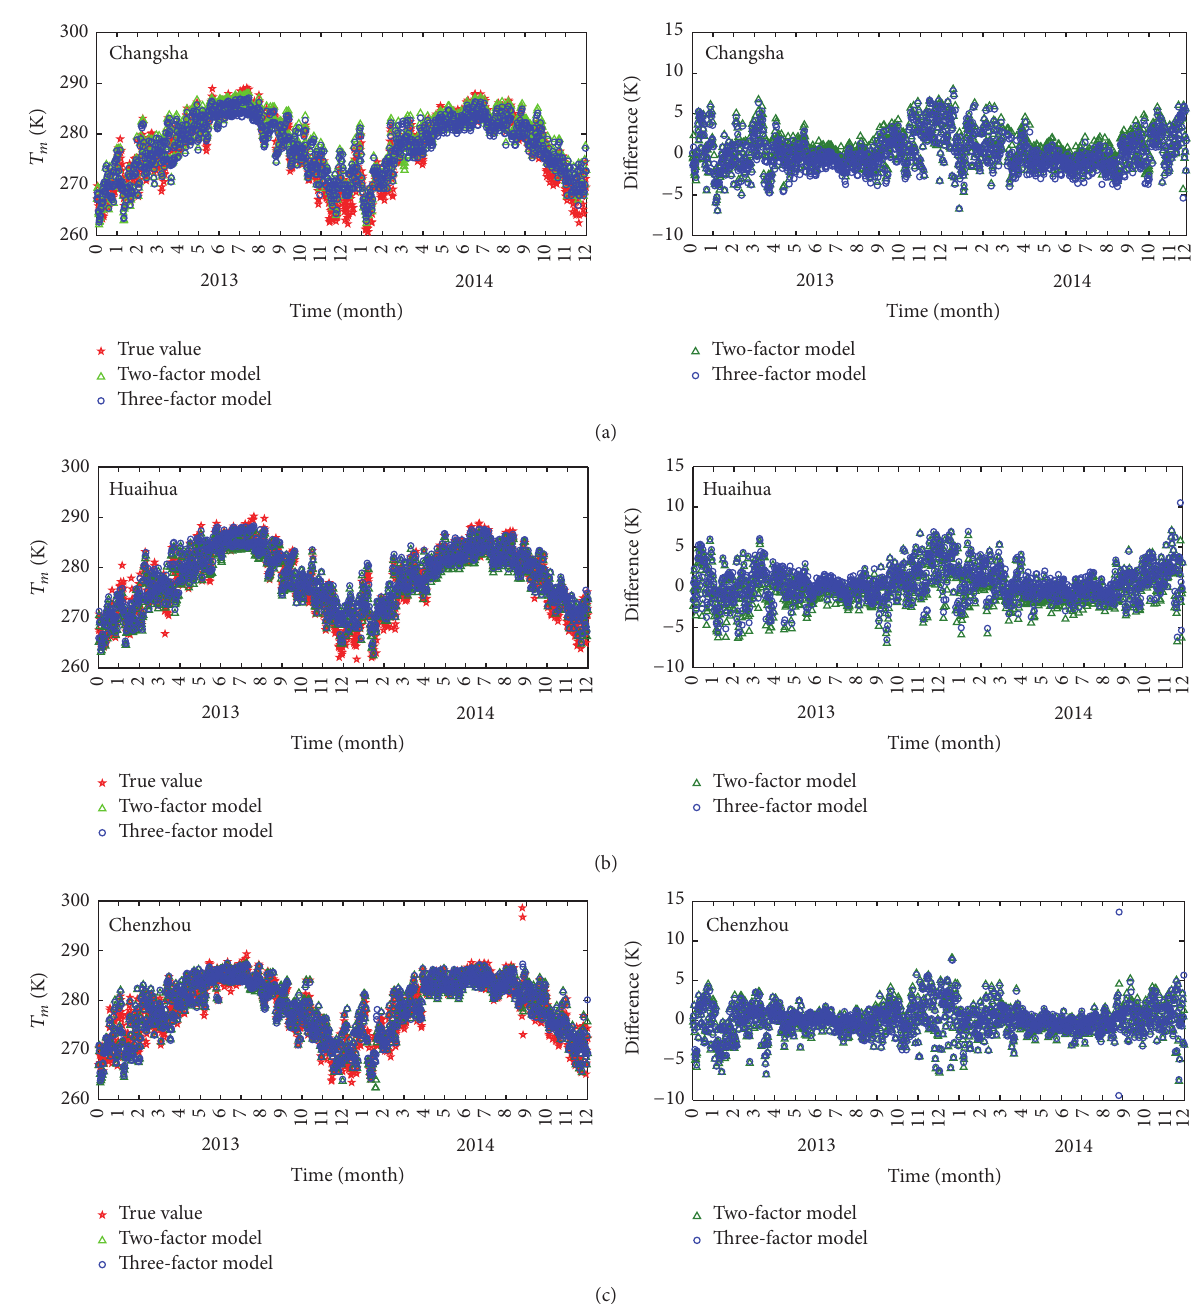
Figure 6: Comparison of the three 𝑇 𝑚 time series (left) and the differences of the two-factor and three-factor RTMs from the radiosonde- derived 𝑇 𝑚 truth (right) at the three stations: (a) Changsha, (b) Huaihua, and (c)